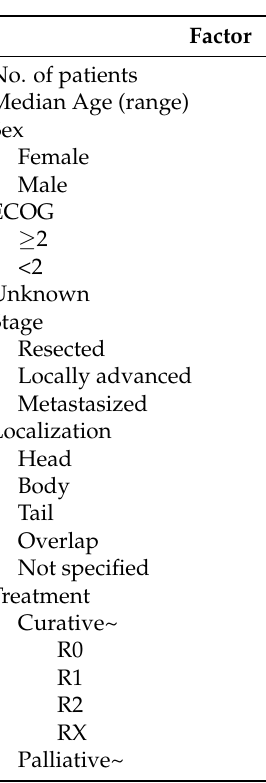
Table 1. Descriptive statistics of study